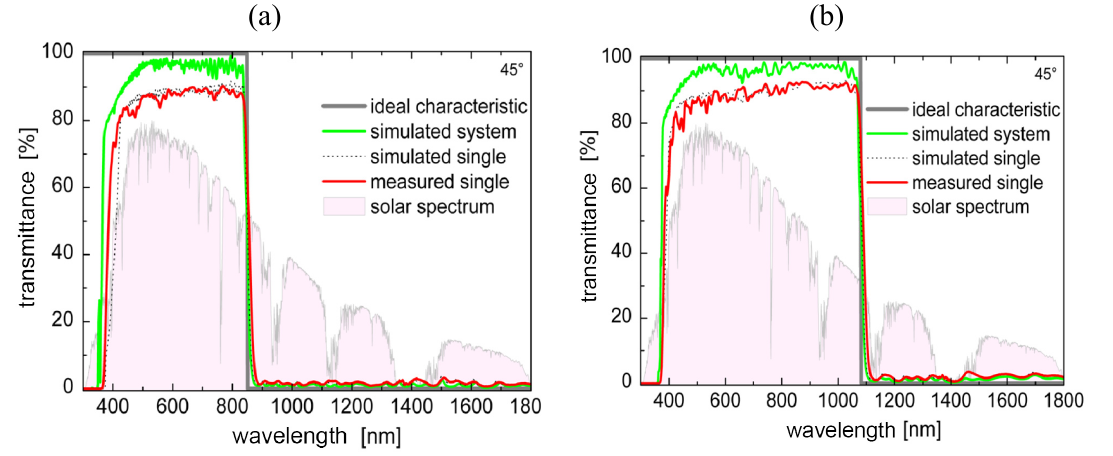
Figure 11. Optical transmission of spectral beam splitter (a) and (b) as used in the prototype with edge wavelength at 850 (1,080) nm. The blue line shows the simulated characteristics as is the case in a system set up with 45° incidence angle. The red line shows the measured transmissions of the fabricated beam splitters with back reflections of the filter substrate glass while not connected to the solar cells. The measured characteristic is close to the simulated one (thin dotted black line), showing virtually ideal characteristics. The spectrally weighted transmissions between 380 and 850 (1,080) nm is 96.4% (95.5%) while the reflectance between 850 (1,080) and 1,800 nm is 98.1% (97.2%) Reproduction with permission from B. Gross, the figure appears in